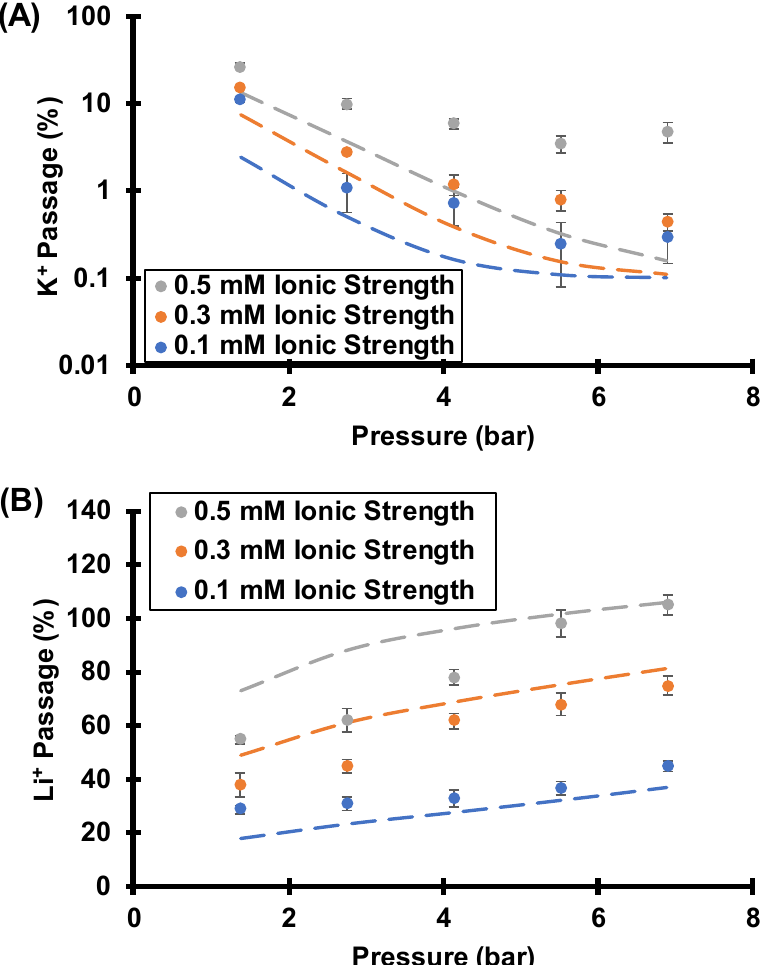
Figure 13. K + ( A ) and Li + ( B ) passages during flow of equimolar KCl and LiCl mixtures at various ionic strengths through track-etched membranes (30 nm pores) using various transmembrane pres- sures and a 1000 rpm rotation rate. Dashed lines are simulated passages assuming a surface charge density of − 2.2 mC/m 2 , a pore diameter of 30 nm, and a boundary layer thickness of 19.4 µm. The simulation also incorporates a 0.1% membrane defect area. Figure S6 shows fits to the data with a higher boundary layer thickness.